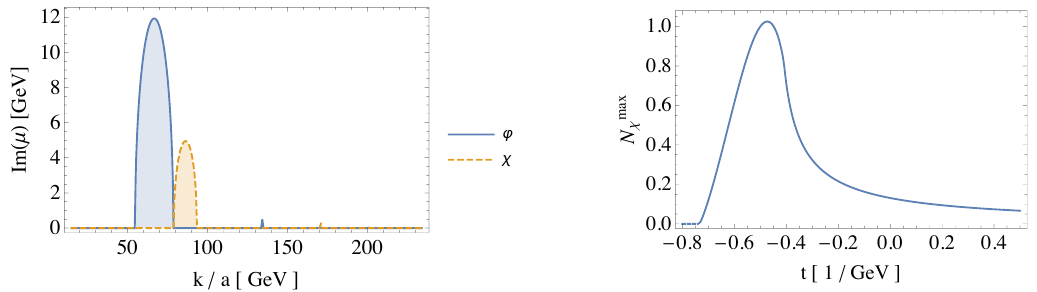
Figure 4 . Left: the characteristic exponents evaluated at t = 0 : 3. Right: the maximum occupation number of (cid:31) for each t